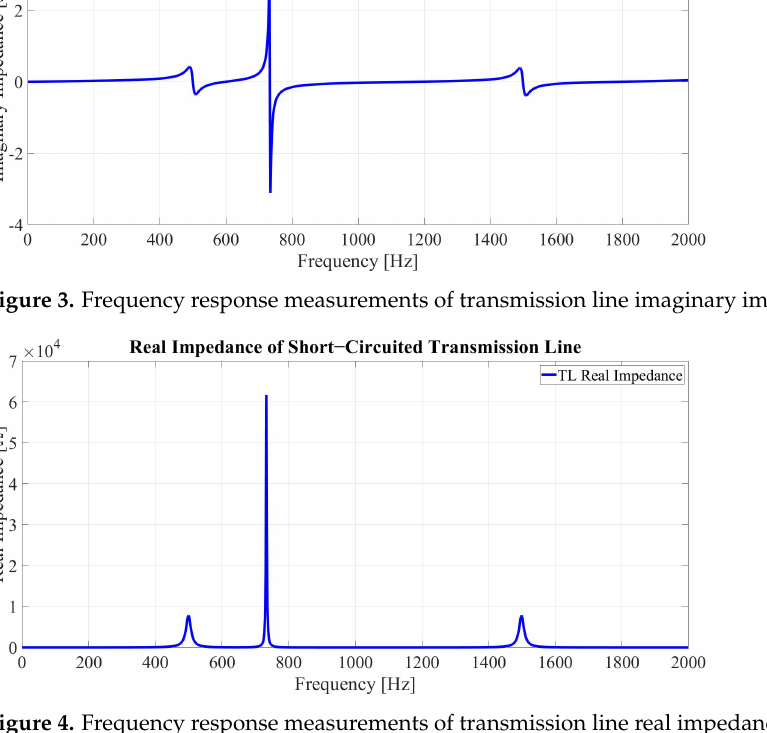
Figure 4. Frequency response measurements of transmission line real